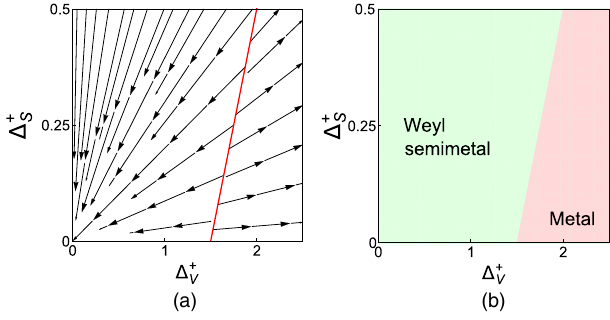
FIG. 15. (a) The renormalization-group flow diagram and − Δ þ (b) corresponding phase diagram in the Δ þ plane obtained V S 1 . The WSM-metal QPT in this from ϵ expansion for ϵ m m ¼ coupling constant space is controlled by the line of QCPs [see Eq. (43)], shown by the red line in (a) that in turn also determines the phase boundary between these two phases, as shown in